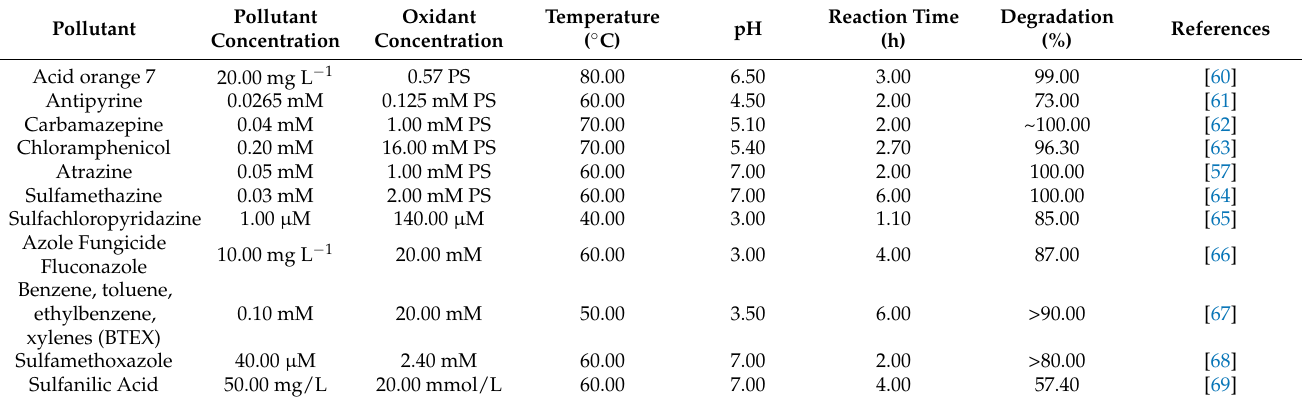
Table 2. Thermal activation of persulfate for degradation of